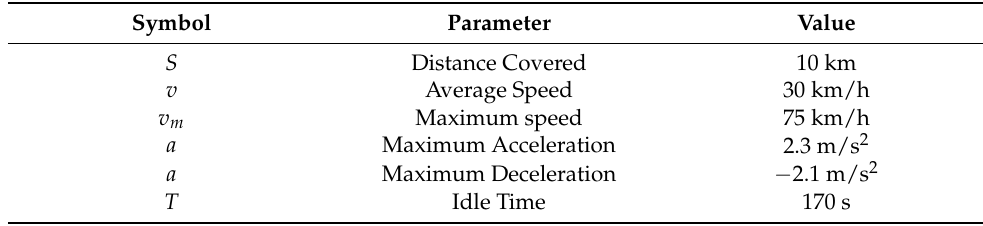
Table A1. Driving Cycle Parameters.